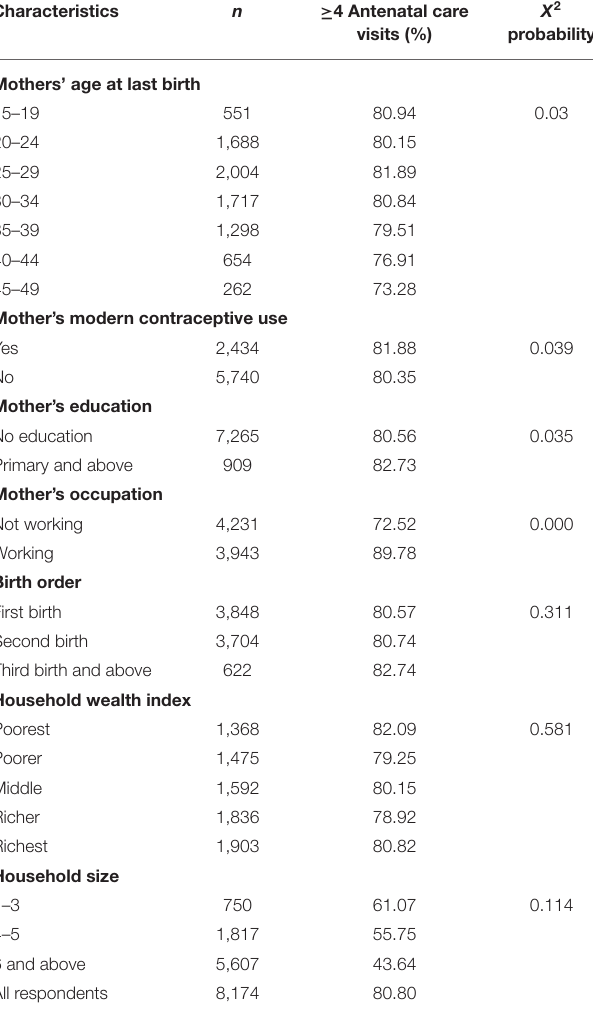
TABLE 2 | Variations in indicators of the use of antenatal care (ANC) services, by selected individual and household characteristics. Characteristics